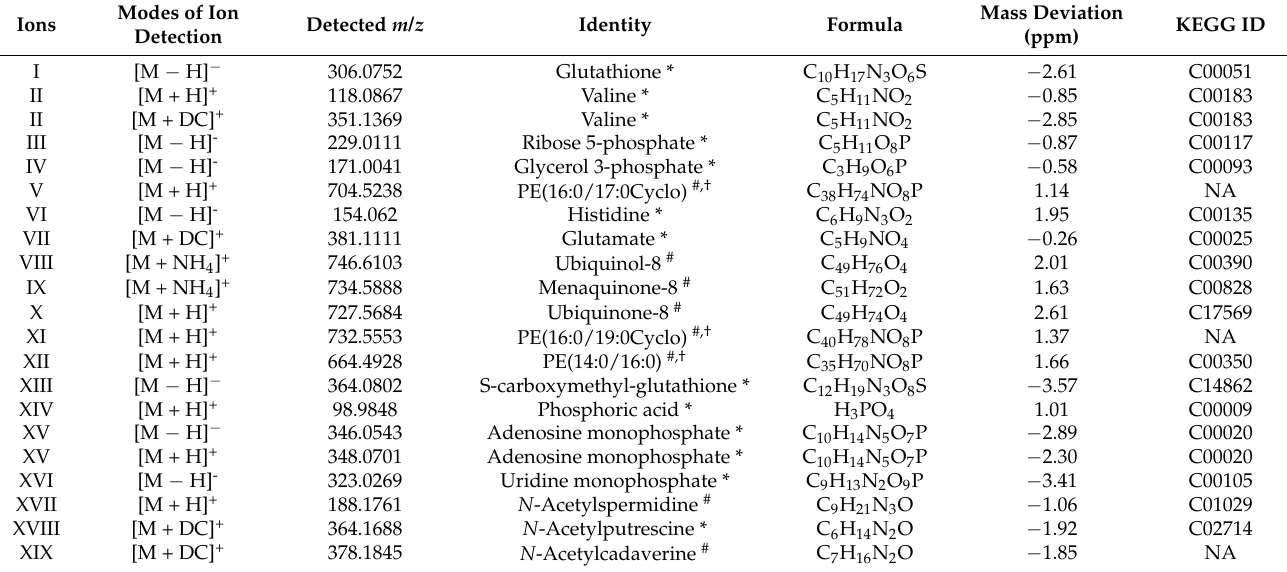
Table 1. Detection and identities of IPL-responsive metabolites in the E. coli metabolome. The metabolite markers were detected in four different modes, including positive-mode detection of protonated metabolites ([M + H] + ) in aqueous extracts, negative-mode detection of deprotonated metabolites ([M − H] − ) in aqueous extracts, positive-model detection of dansylated metabolites ([M + DC] + ) in aqueous extracts, and positive-mode detection of both protonated ([M + H] + ) and ammonium ([M + NH 4 ] + ) adducts in lipid extracts.